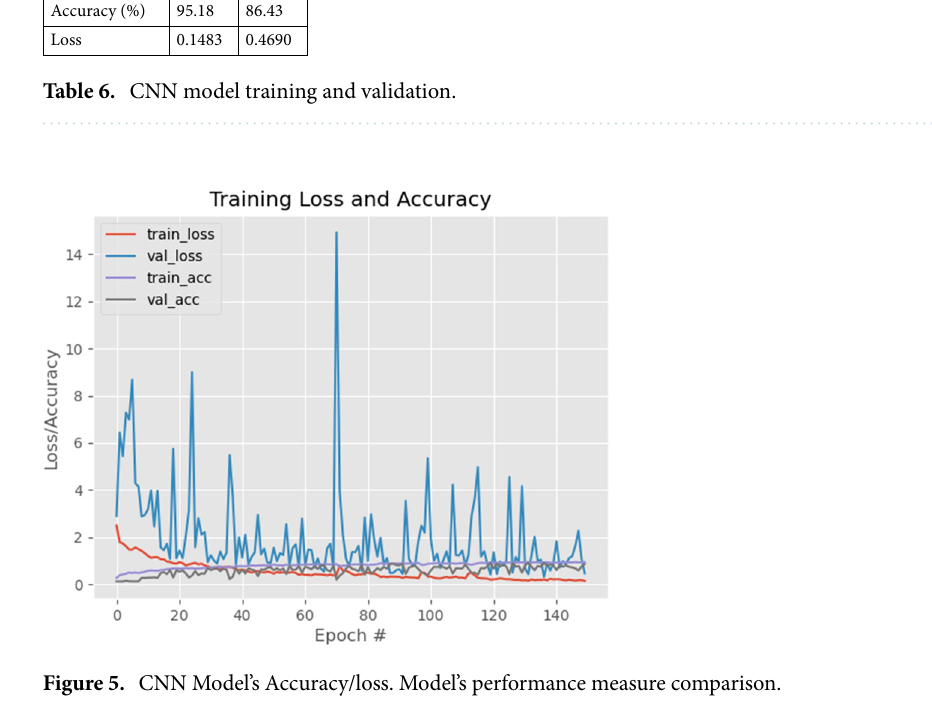
Figure 5. CNN Model’s Accuracy/loss. Model’s performance measure comparison.